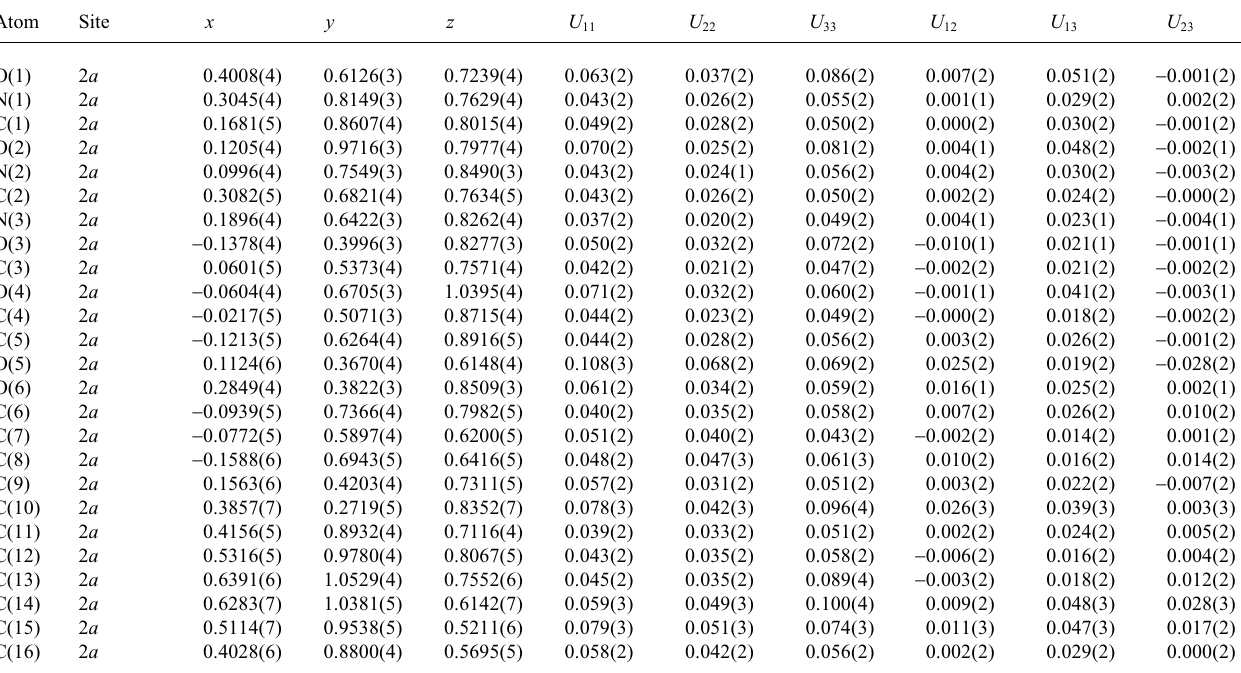
Table 3. Atomic coordinates and displacement parameters (in Å 2